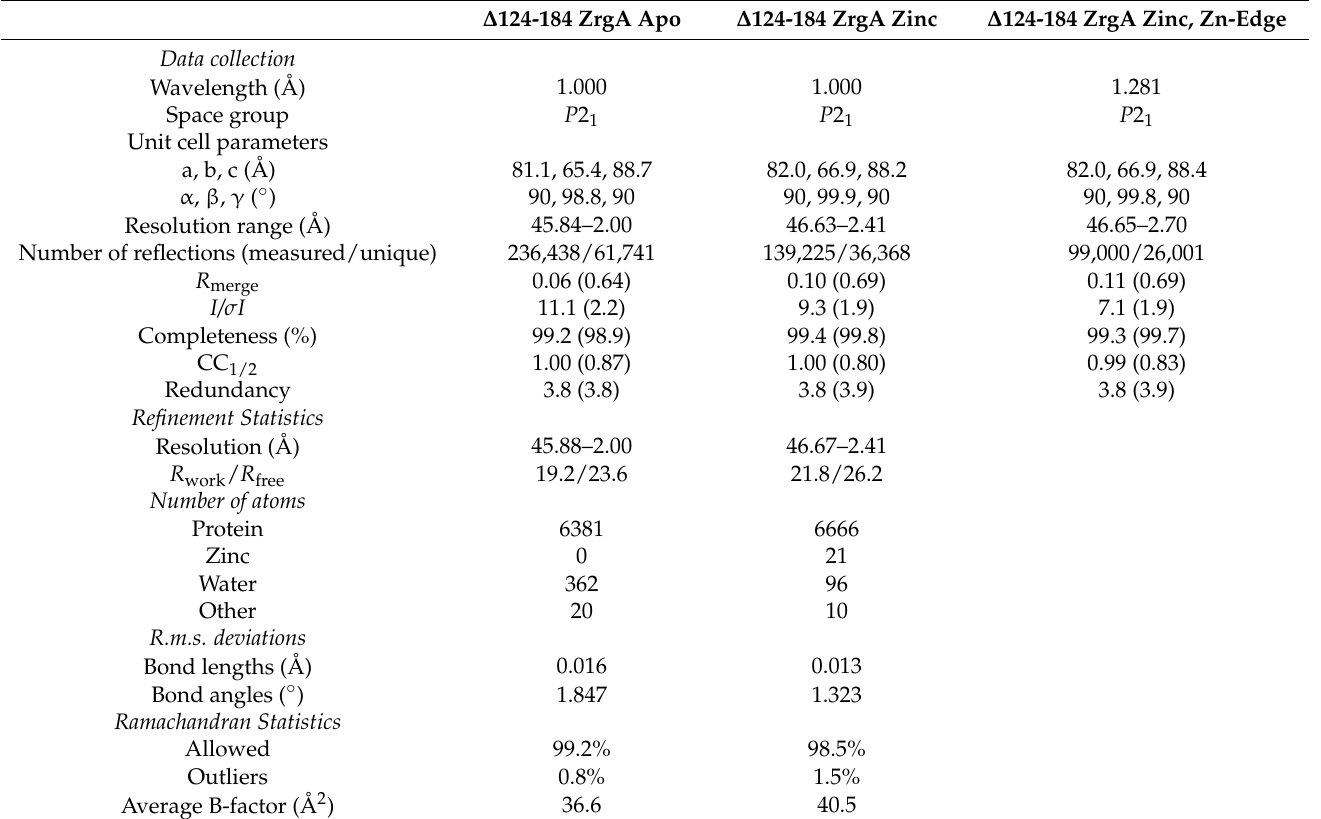
Table 2. Data collection and refinement statistics for ZrgA crystal